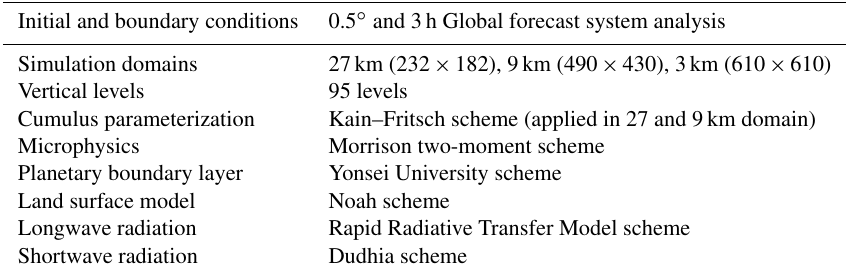
Table 1. WRF Model Configuration and Physics